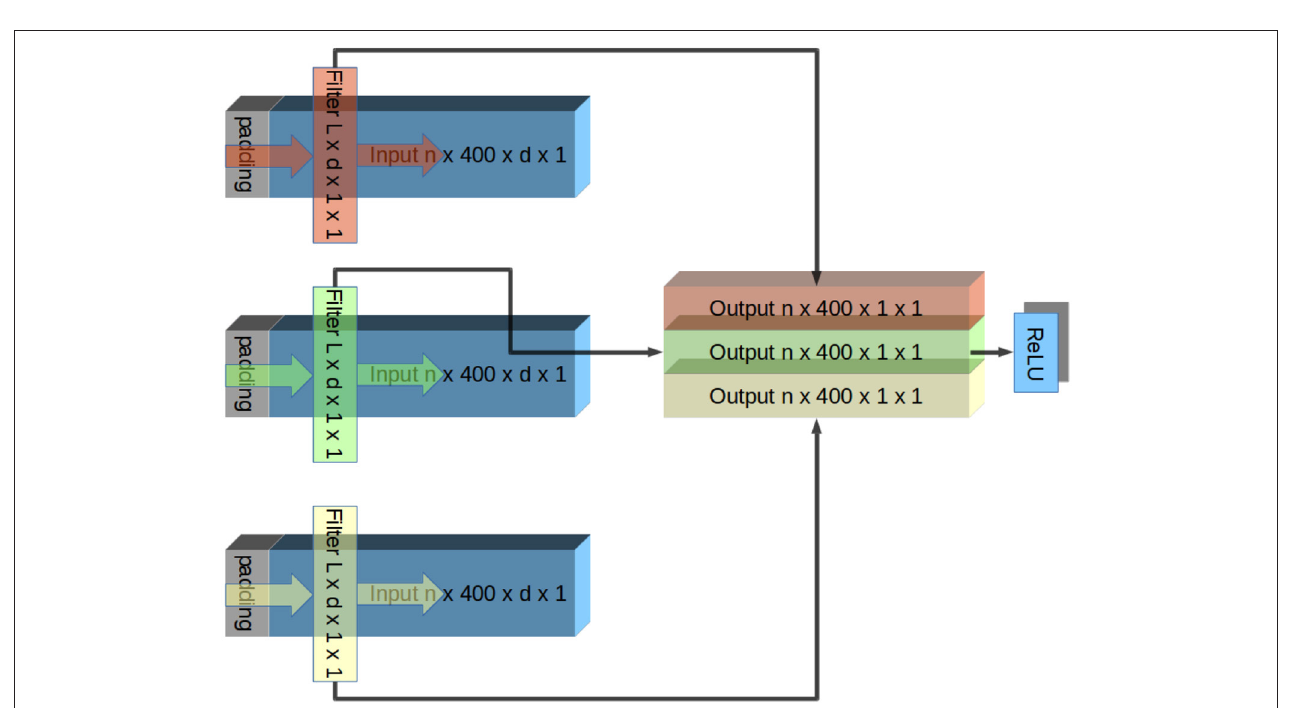
FIGURE 3 | Illustration of one layer of CNN. The input signal has n trials, each containing d channels. In this illustration, this input is padded and convolved with a different filter per output channel. Each filter has an identical width as inputs (d), and therefore the convolution produces a single channel of output. Because the filters apply identically to each trial, the output channel has the same number of trials as the input. Output channels are grouped together and fed into element-wise ReLU rectification. Output of ReLU is the input to the next layer. This repeats until the output is a single channel, which is compared to a low-pass filtered EMG signal. Convolution in Tensorflow proceeds right to left due to conventions of CNNs. To account for this, inputs are flipped before the convolution and outputs are flipped again afterwards.